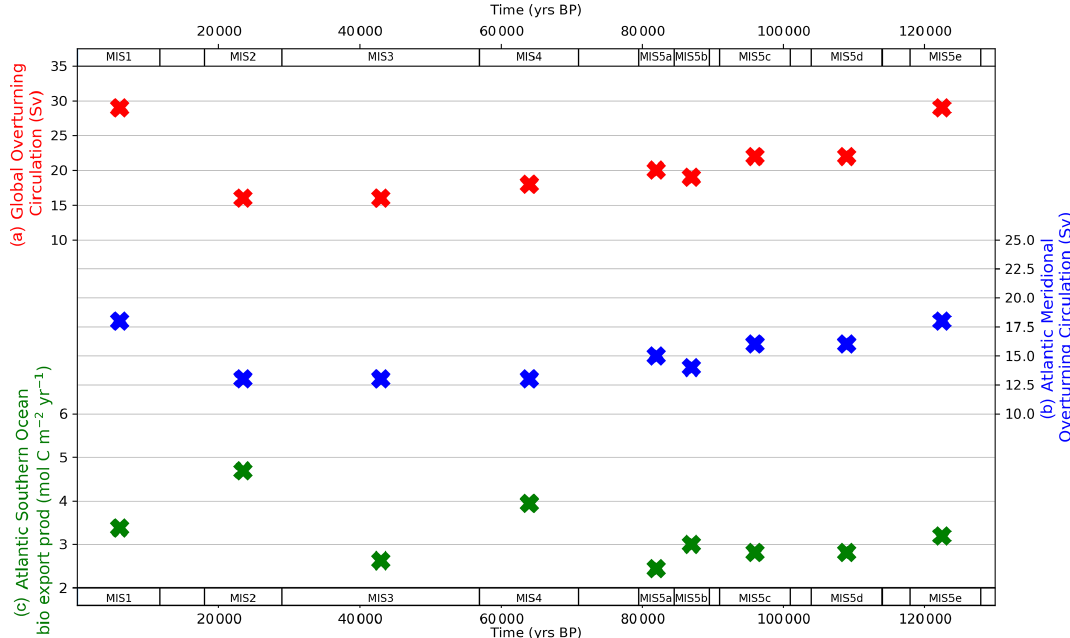
Figure 8. Model–data experiment results for global overturning circulation (a) , Atlantic meridional overturning circulation (b) and Atlantic Southern Ocean biological export productivity (c) . “X” symbols mark the optimal parameter values returned from the model–data exper- iments. The optimized values take account of data variance, due to the weighting of proxy data points by their standard deviation in the model–data optimization equation (Eq. 3). Data for optimized parameter values shown in the figure are contained in Table